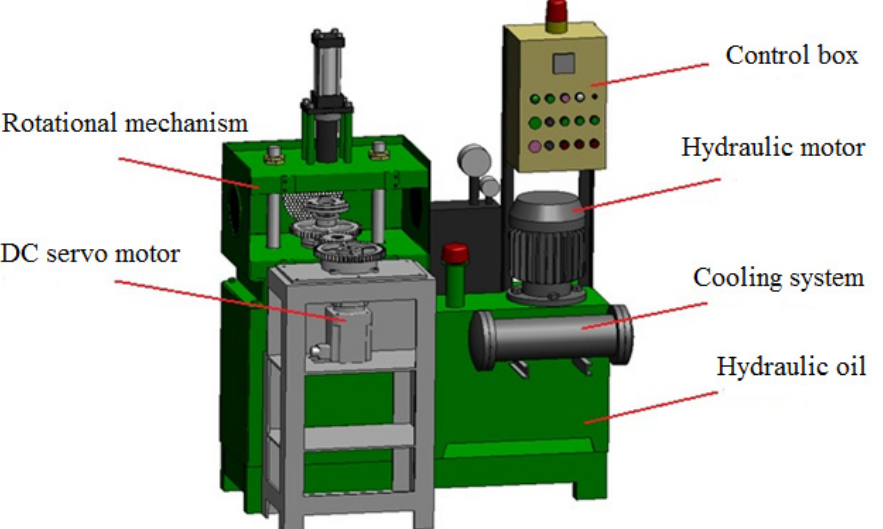
Figure 1. AFM with a rotational mechanism and control system.